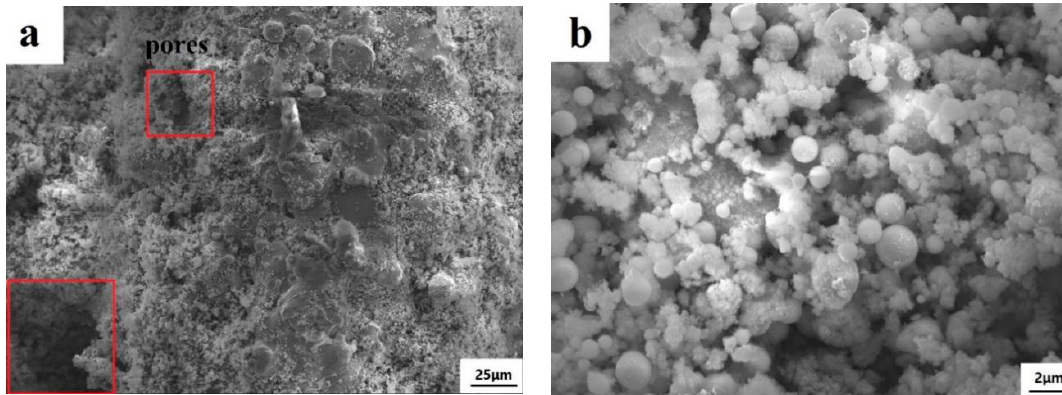
Figure 10. Surface morphology of the coating surface on wire-mesh ( a ): Low magnification, ( b ): Magnified observation.